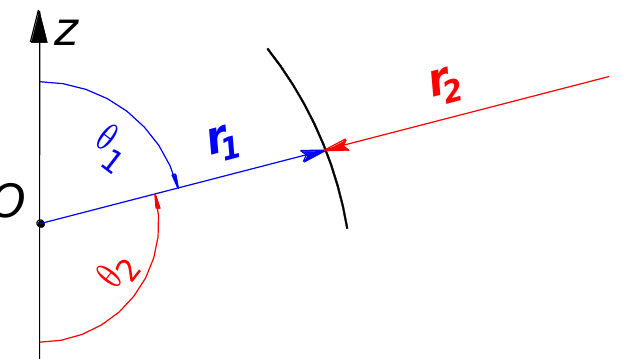
Figure 4. The illustration of the positive (blue) and negative (red) values of the radial distance ( r ) and polar angle ( θ ).